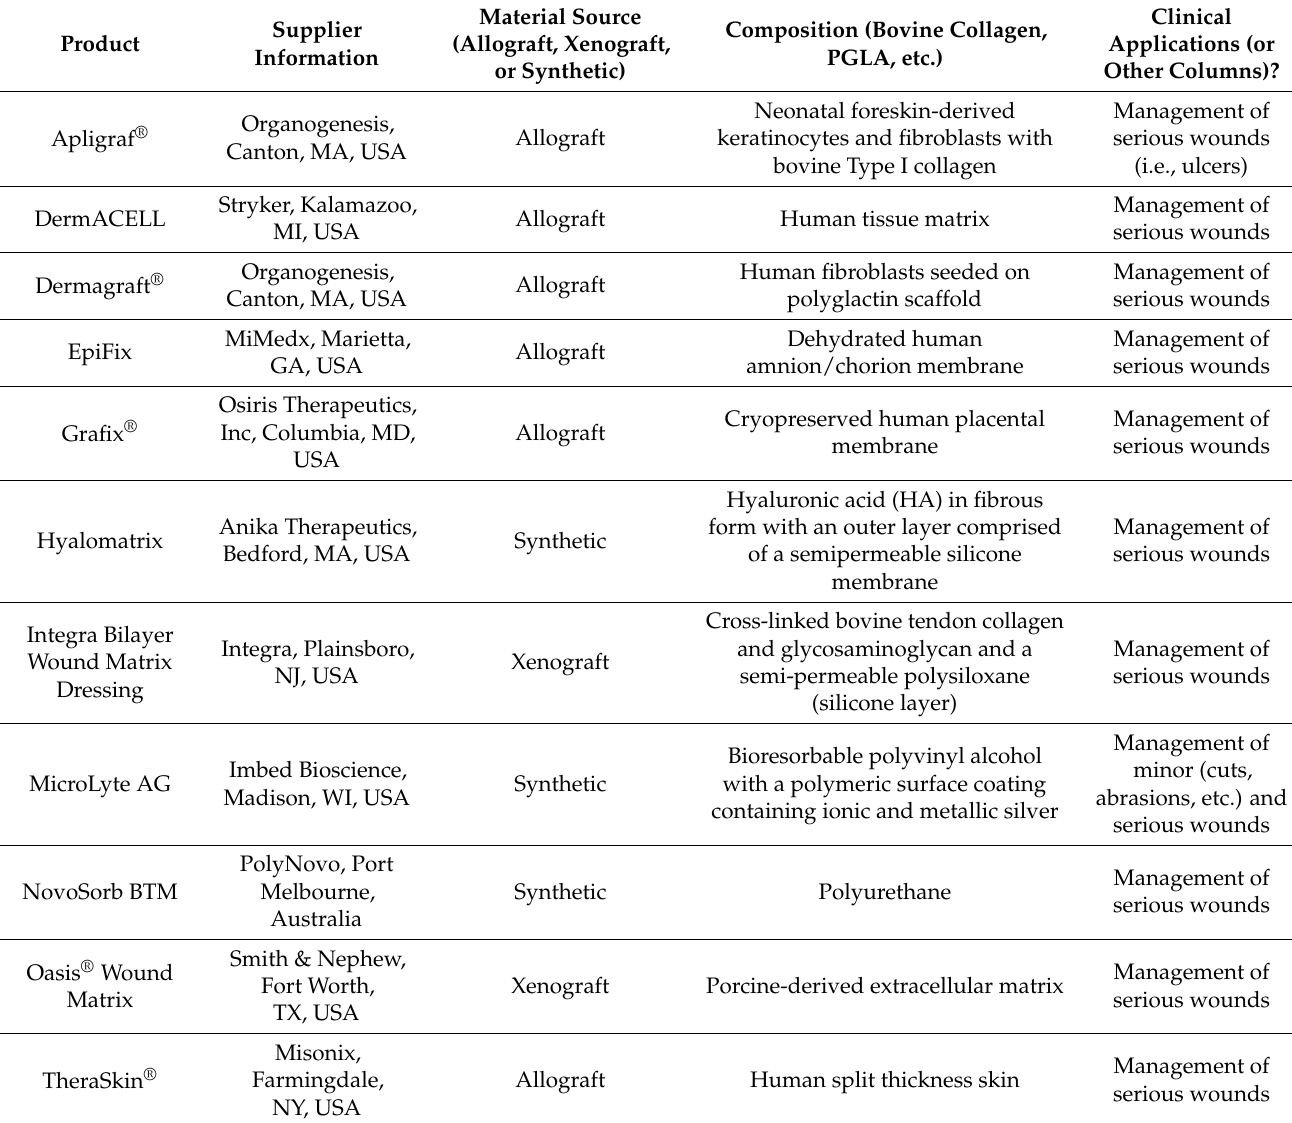
Table 1. Select available wound healing